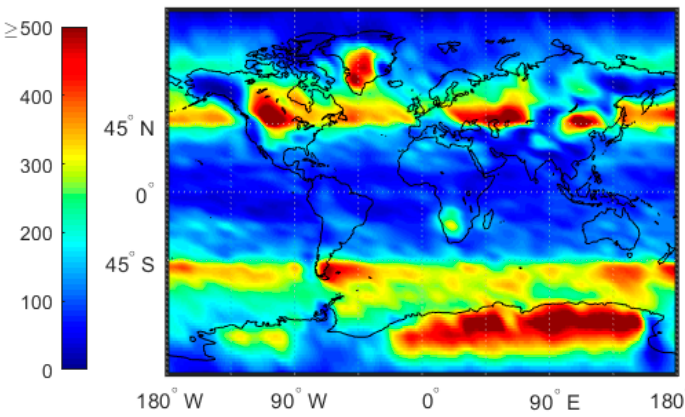
Figure 1. The number of COSMIC GPS-RO profiles from 2007 to 2011 for which the signal penetrates to below 500 m above the surface. The color bar represents the number of profiles. to below 500 m above the surface. The color bar represents the number of